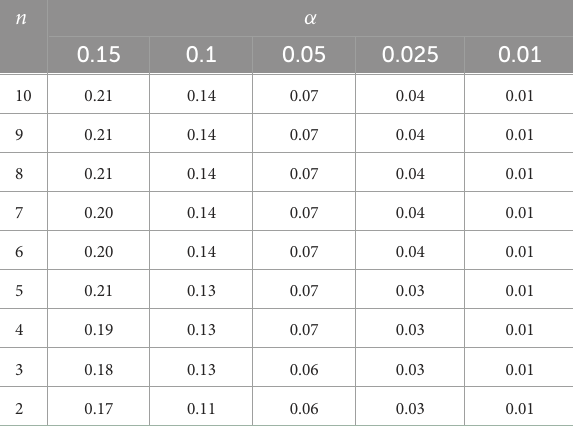
TABLE 2 Convolution power of the VIC test relative to the hypothesis H 1